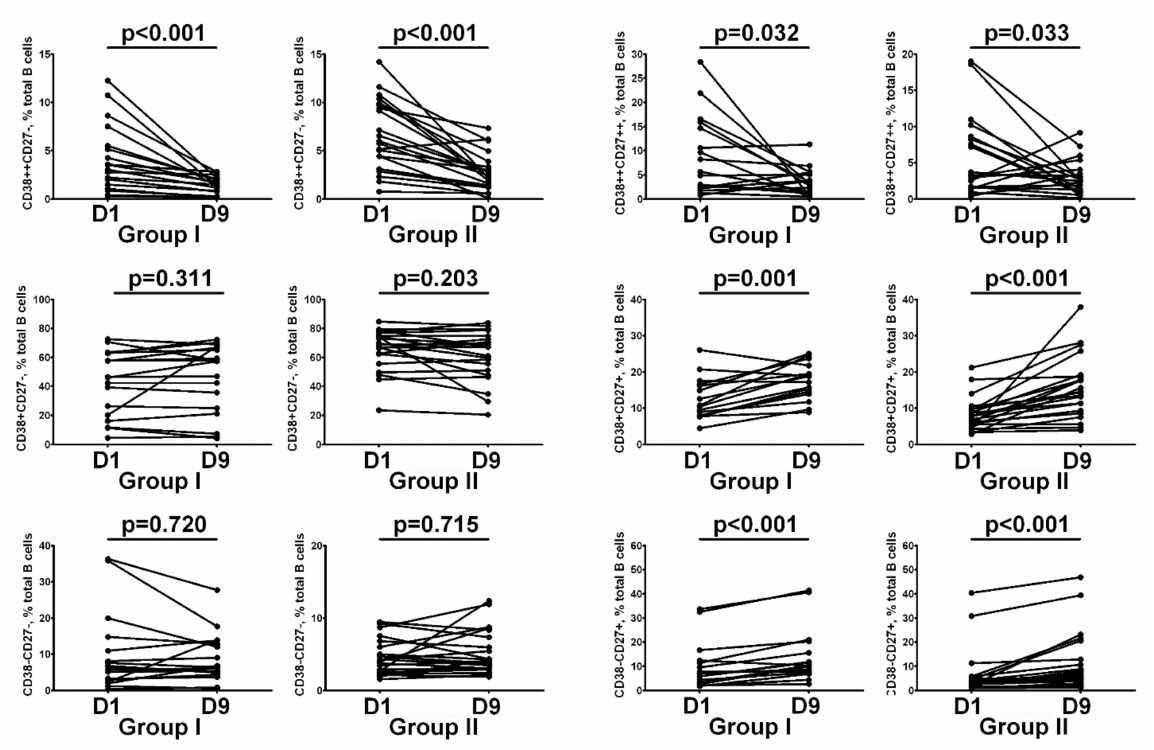
Figure 4. Main B cell subsets frequencies before and after 100,000 IU cholecalciferol supplementation. Numbers represent the percentages of the indicated B cell subset among the total B cell population. Each pair of connected points represents an individual subject. Day 1 vs. day 9 post-hospitalization intra-individual patient samples were compared by Wilcoxon matched-pairs signed rank test with two-tailed p